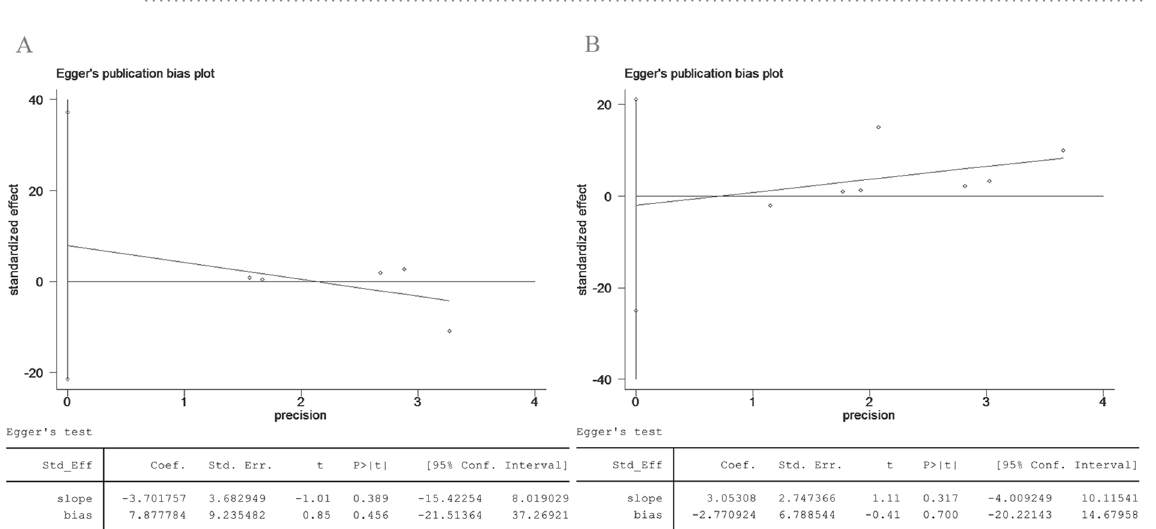
Figure 7. Forest plots for other postoperative complications in the T3 and T4 groups. ( A ) Recurrence, ( B ) dry hands and ( C ) gustatory sweating.